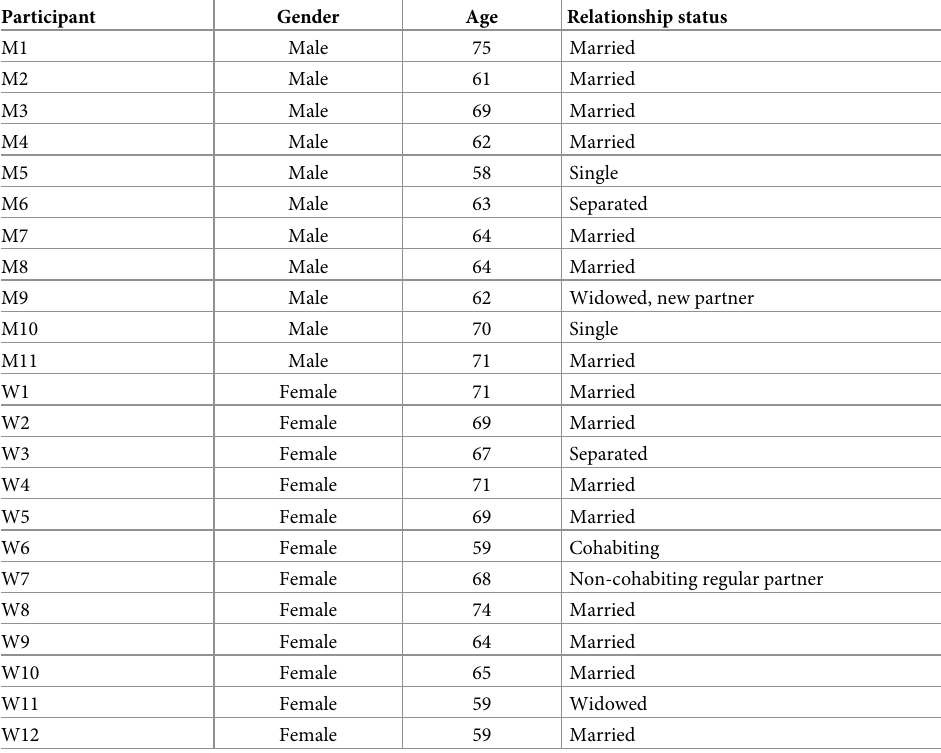
Table 1. Characteristics of in-depth interview